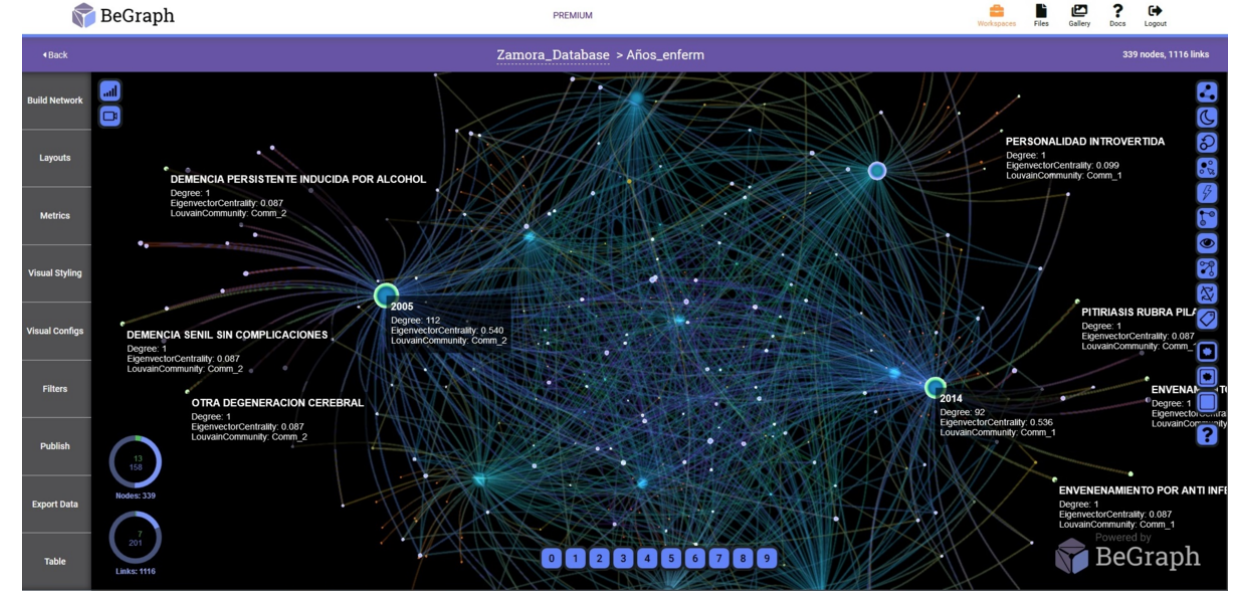
Figure 2. Network with prevalent diseases-years in the Assistance Complex of